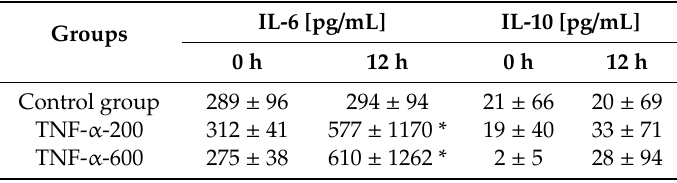
Figure 2. ( a ) 1-butanol during observation period. * p < 0.05 for TNF- α -200 and TNF- α -600 vs. control group; ( b ) 1-pentanol: *# significant increase of 1-pentanol intensity for both TNF- α groups vs. baseline and vs. control group; ( c ) Course of p-cymol intensity: * p < 0.05 TNF- α -600 vs. control group. § p < 0.05 TNF- α -600 vs. TNF- α -200. Data presented as means ± SEMs. N = 10 per group at the beginning of the experiment.